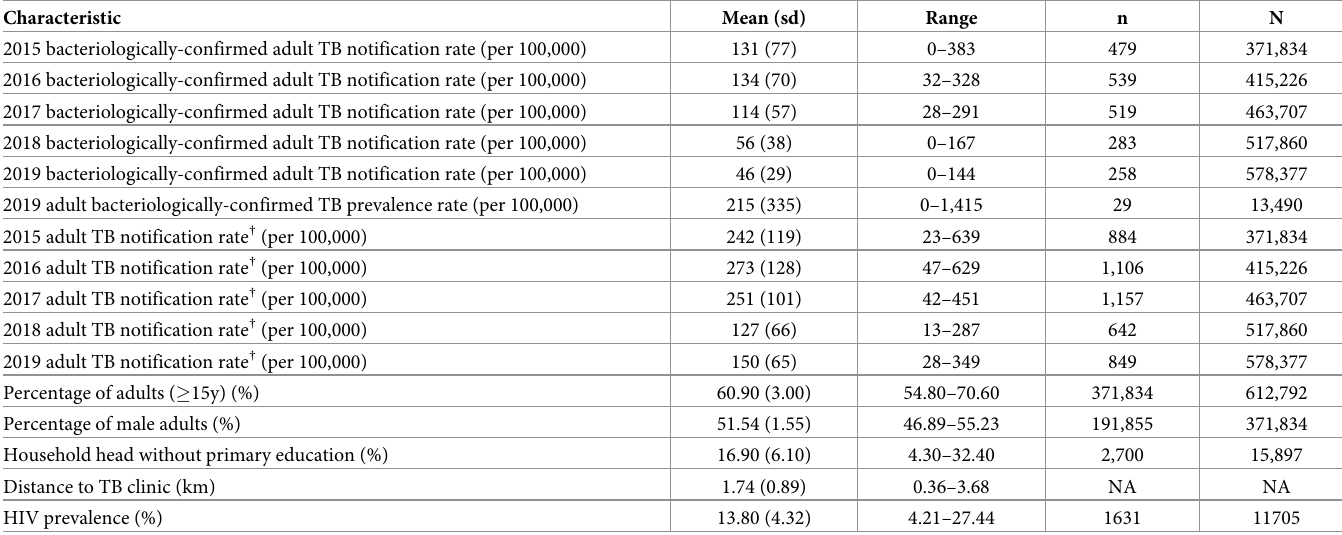
Table 1. Neighbourhood-level summary data for the 72 neighbourhoods.